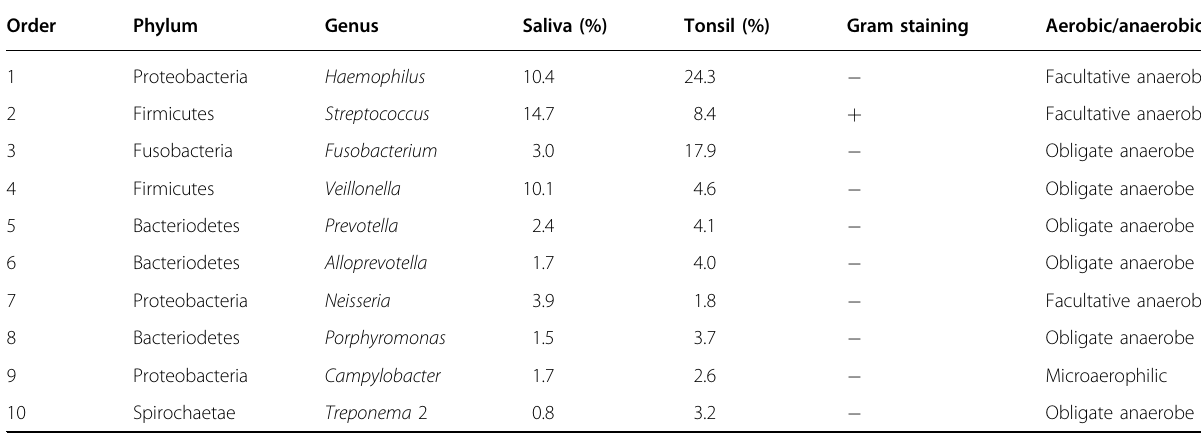
Metastats analysis of the abundance of bacterial taxa detected in saliva and tonsil tissue samples from the two groups.